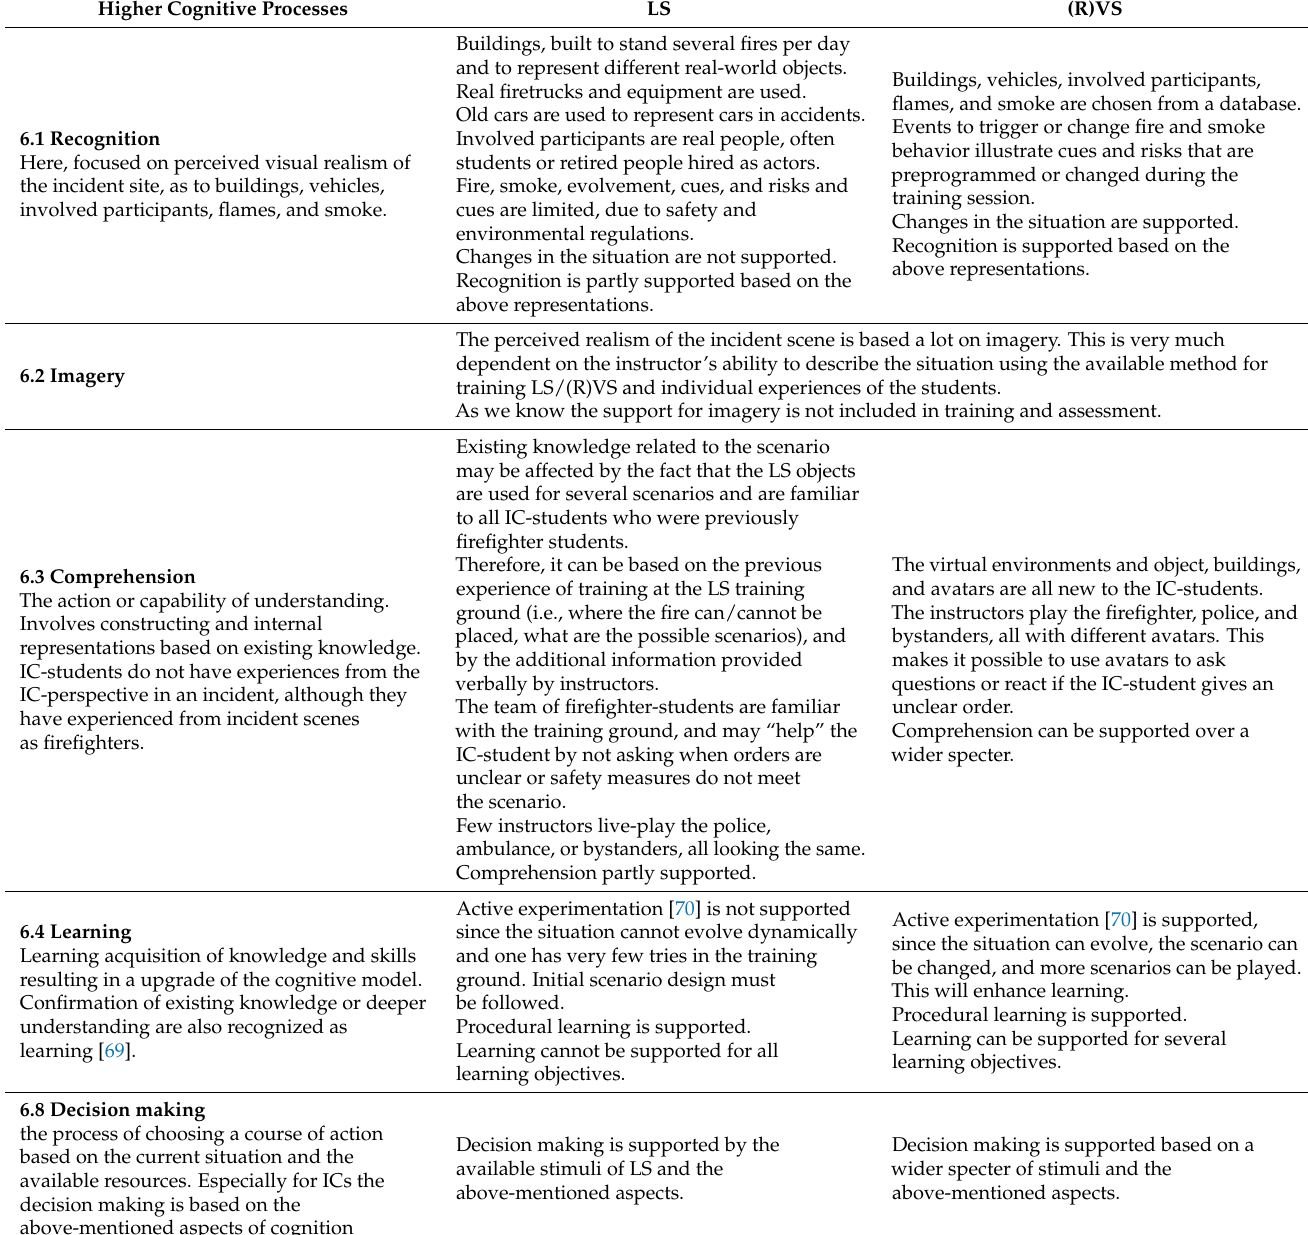
Table 5. Higher cognitive processes are supported in LS and